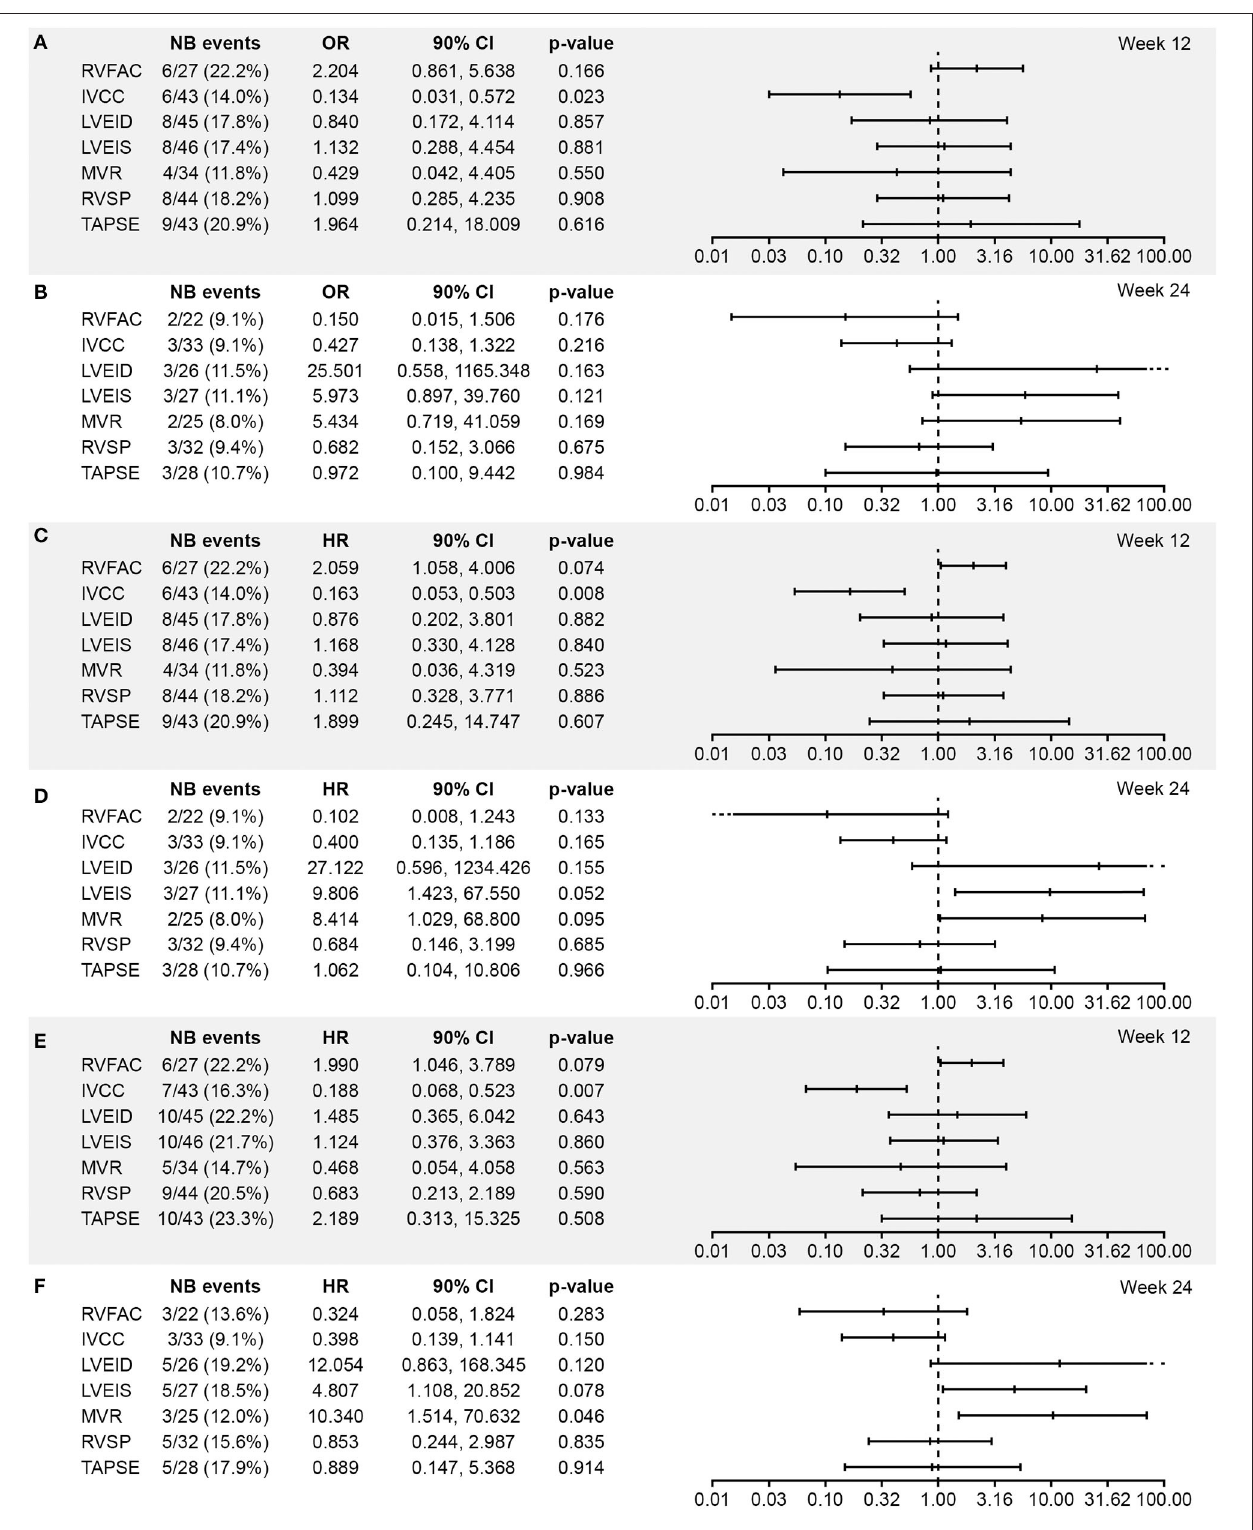
FIGURE 1 | Association between worsening from baseline in echocardiographic parameters and (A,B) vital status at EOS, (C,D) time to death, and (E,F) time to PAH worsening at Weeks 12 and 24, respectively (all randomized set; N = 64). Analysis based on logistic regression for ORs and on Cox models for HRs. The